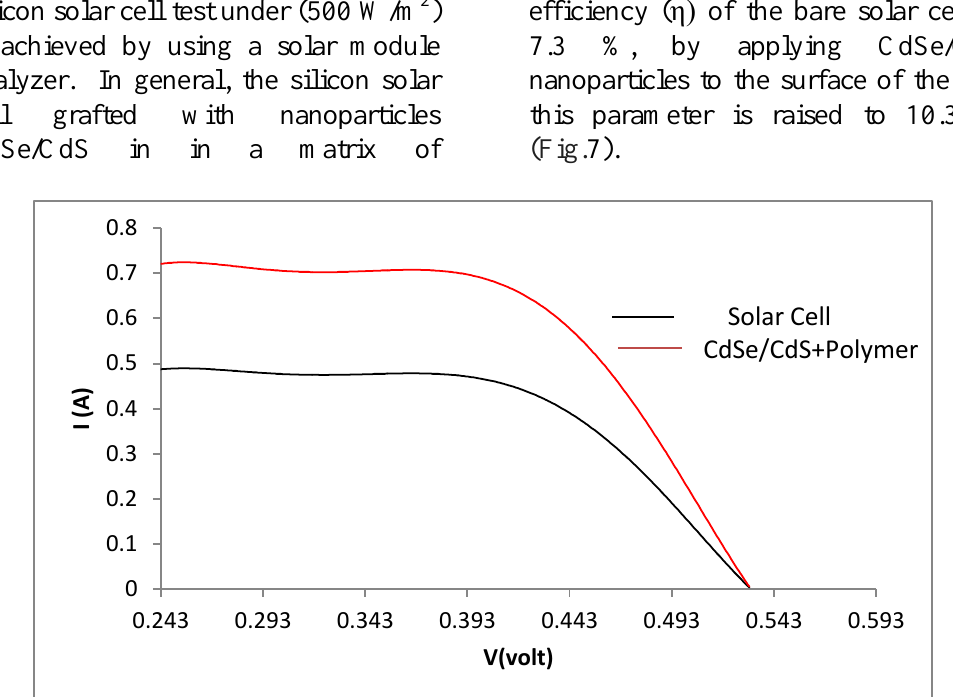
Fig.7: I-V characteristics curves for both a bare solar cell and covered with CdSe/CdS core- shell sheet. Table 2: I ,V , and η for the solar cell and solar cell +CdSe/CdS core/shell. sc oc Type Solar